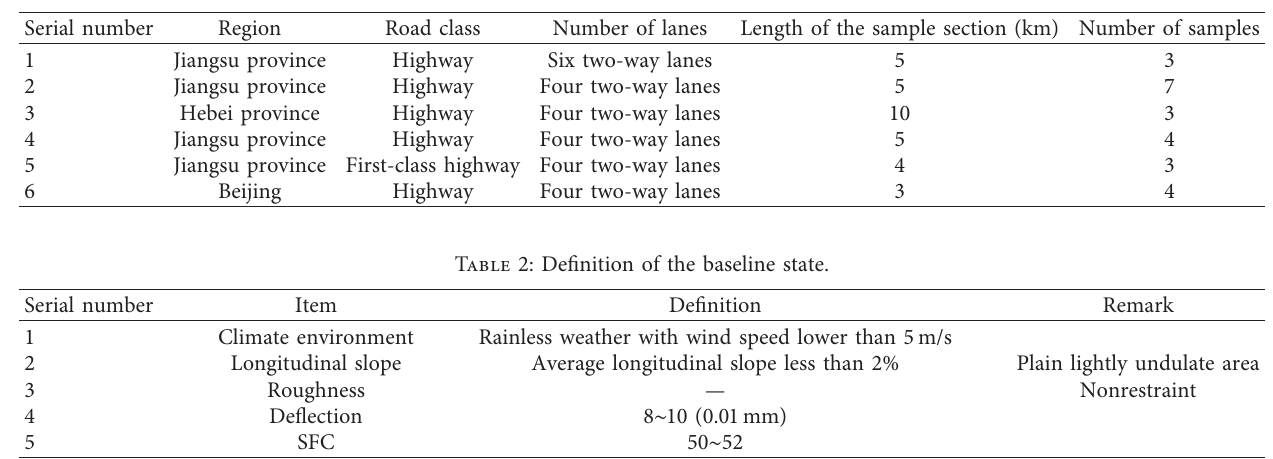
Figure 2: Collection scheme of fuel consumption parameters. (a) Oil-pipe reconstruction. (b) Fuel consumption sensor. (c) Data acquisition device. (d) GPS positioning. Table 1: Survey of sample sections.